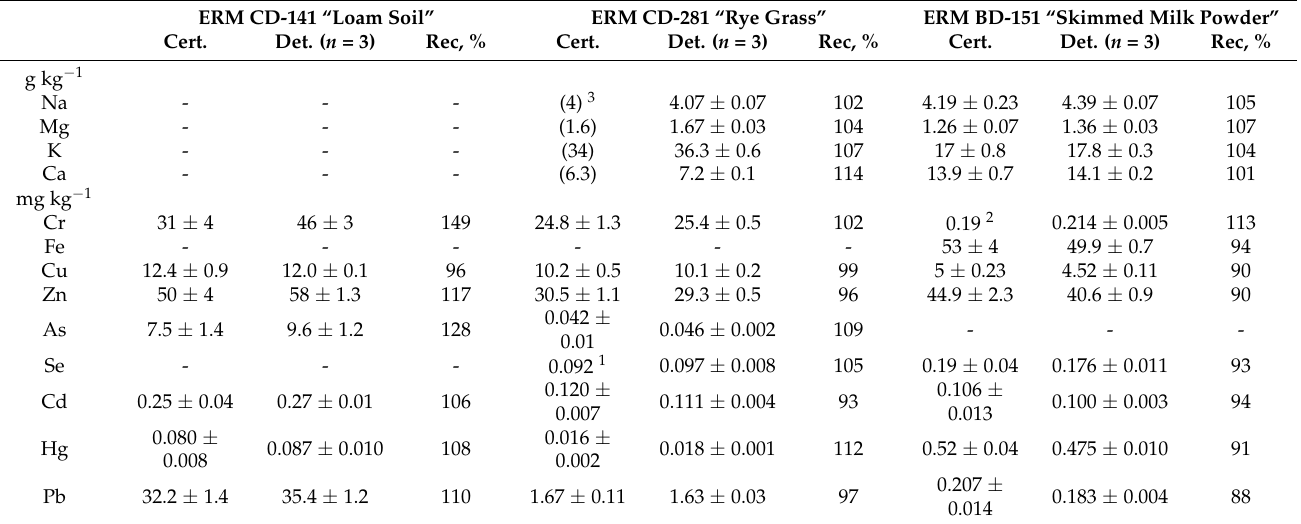
In Table A5, validation statistics are included. Note that for Na, Mg, K, and Ca (ERM CD-281 “Rye-grass”) there was no availability of uncertainty values because these inorganic elements were included as additional material information in the ERM CD-281 report. As detailed in this report, the results were obtained from “ semi-quantitative screening analysis using ICP-SFMS ( . . . ). The elements were determined using 18 scans over the mass range, resulting in a total measurement time of 300 s. The results are an average of triplicate measurements ”. Table A5. Method validation statistics for ERM-CC141 (loam soil), ERM-CD 281 (rye grass), and ERM BD-151 (skimmed milk powder) analysis by ICP-MS. ERM CD-141 “Loam Soil” ERM BD-151 “Skimmed Milk Powder” Cert.